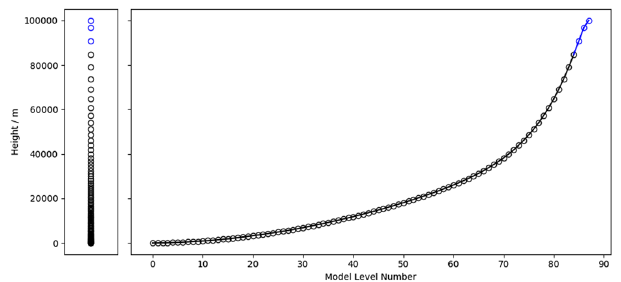
Fig. 3. Vertical level sets for the standard model height (black) and those added for the raised model height (blue). Two levels are added conforming to the 85 km level distribution, whilst the fi nal is placed at 100 km.